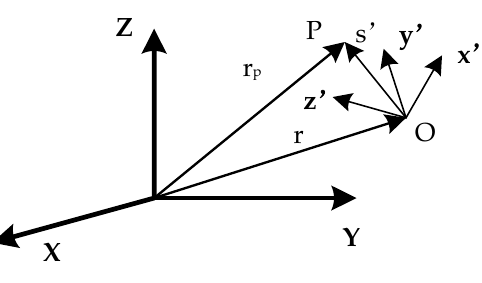
Figure 8. Coordinate diagram.